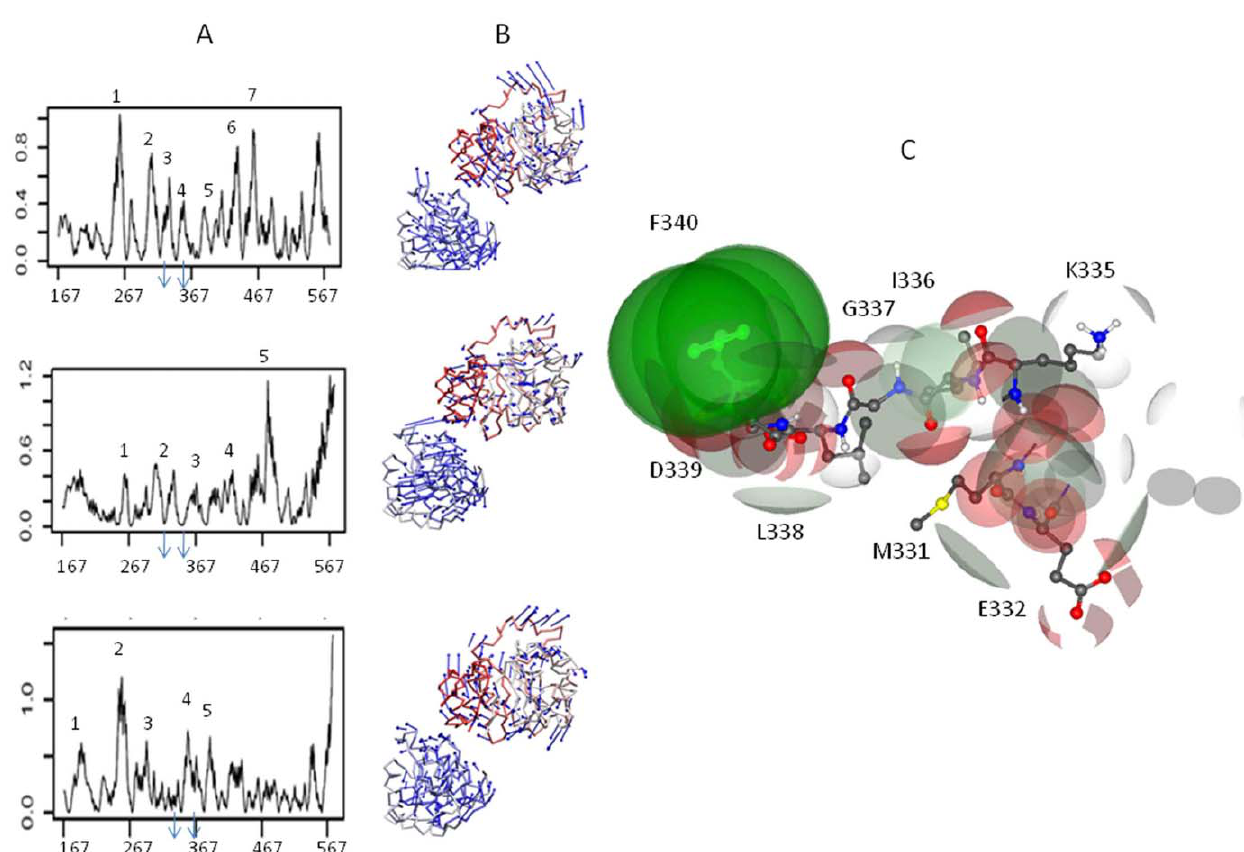
Figure 6. Role of functional residues at RNA binding site of DDX3X. A) Normal mode analysis of DDX3X with modes having lowest deformation energy values selected. Vector fields representation to show the residues wise displacement in DDX3X. B) Cavity identification at the RNA binding region and selection of potential electron donors and acceptors. C) Hydrogen donors: White, Hydrogen acceptors: Red, Aromatic: Green. charge distribution, calculated using ArgusLab as shown in Figure 6C. Important electron donors and acceptors belonging to crucial functional residues were highlighted.